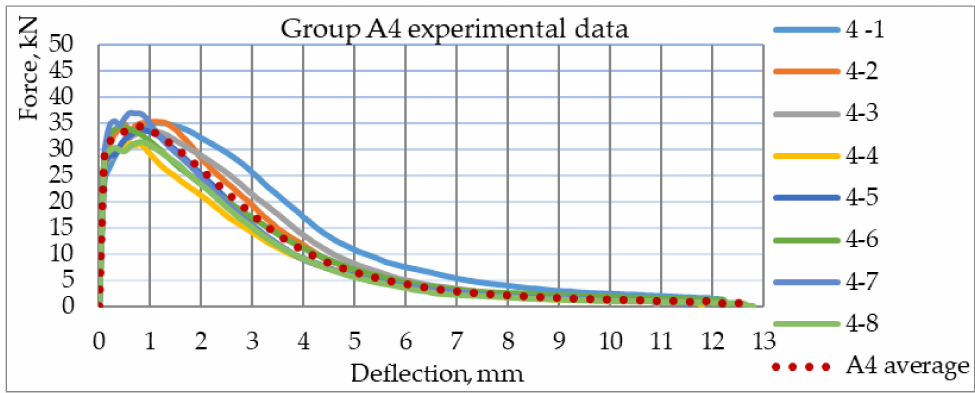
Figure 18. Load—sample center vertical deflection graphs for the specimens in Group